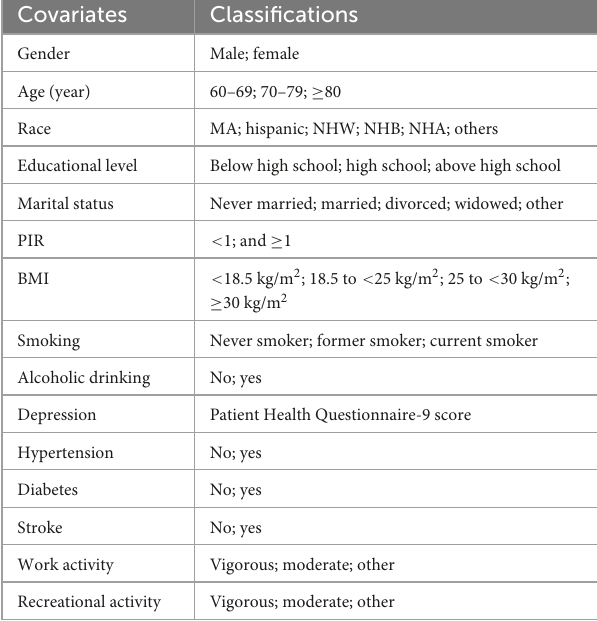
TABLE 2 The classifications of covariates.